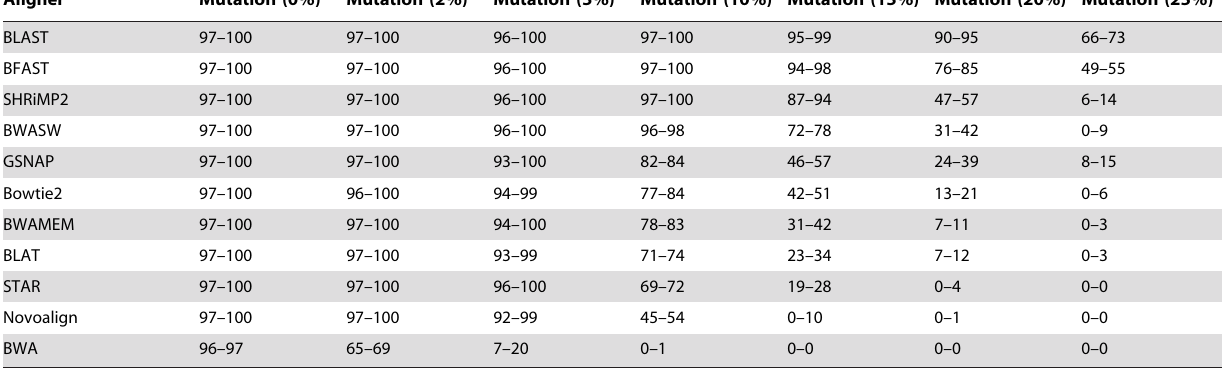
Table 5. Genome Coverage.